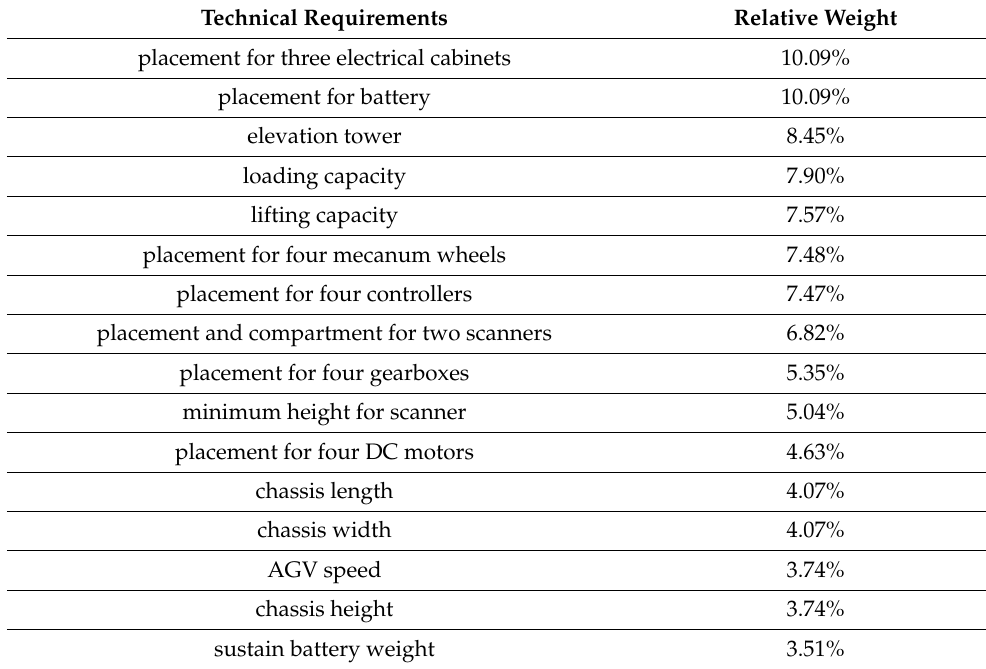
Table 4. Client/customer requirements combined results. Technical